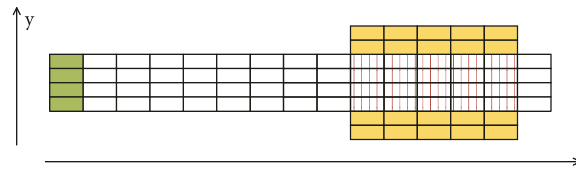
Figure 7: Illustration of initialization of bicycle and pedestrian travel.